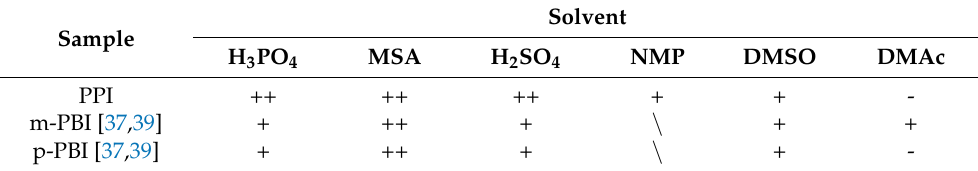
Table 2. Solubility behavior of PPI.